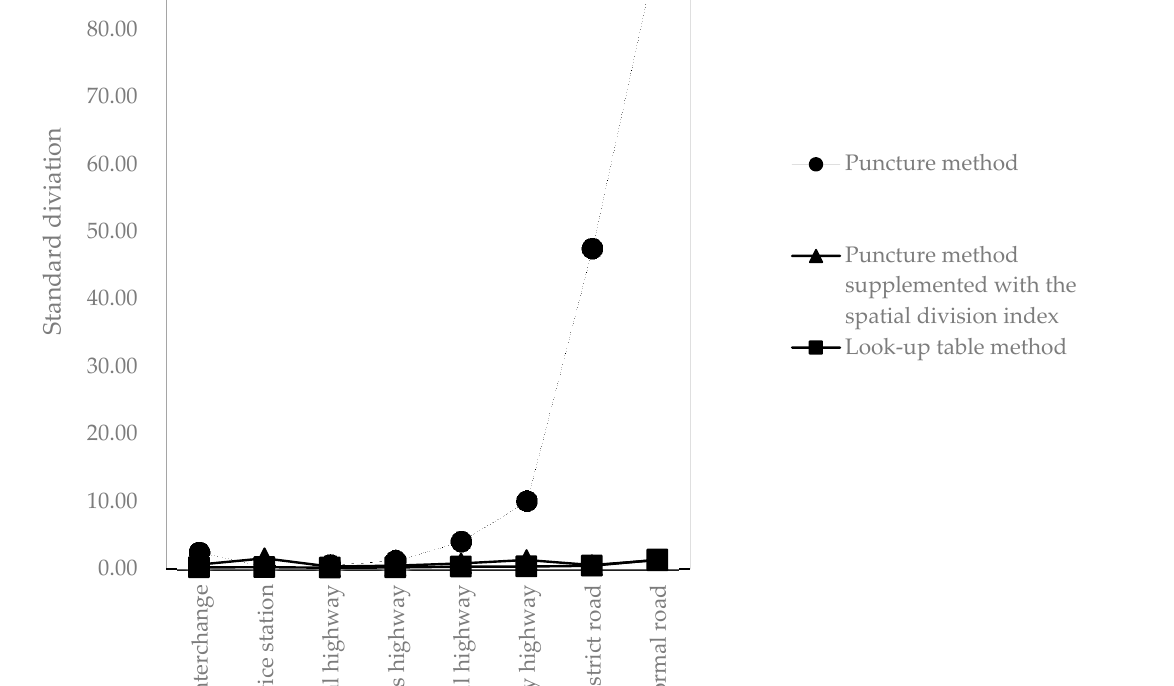
Table 6. Two groups using 100000 samples with 50 runs.